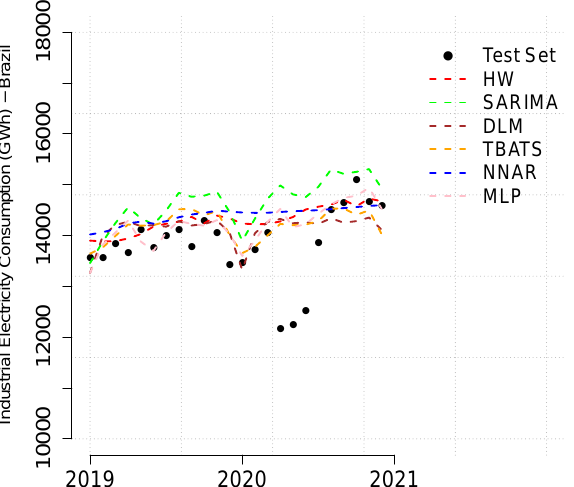
Figure 4. Model forecasting for the six considered models applied to the Brazilian industrial electricity consumption. Table 2. Mean absolute percentage error for the six models under consideration for model fit and model forecasting considering the training and testing data, respectively. Model Fitted Forecast